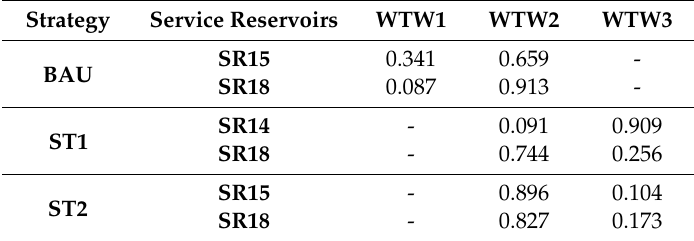
Table 7. Split coefficients between SRs and Water Treatment Works (WTWs) adopted in the BAU and analyzed strategies.